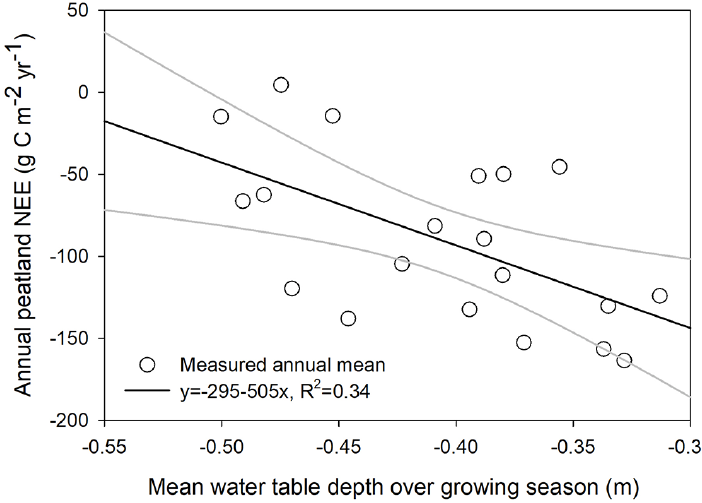
Figure 8. Relationship between annual NEE and peatland water table depth over growing season (May to October) using the measured annual data 1998 to